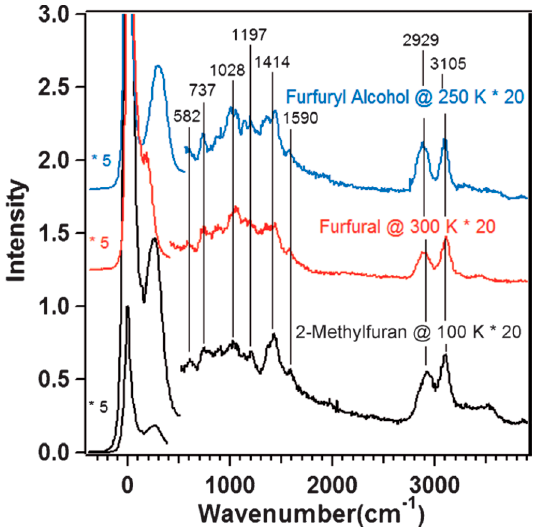
Figure 9. HREELS of furfural (red), and 2-methylfuran (black) and furfuryl alcohol (blue) adsorbed onto Mo 2 C after annealing the surface to various temperatures. Adapted with permission from [56].